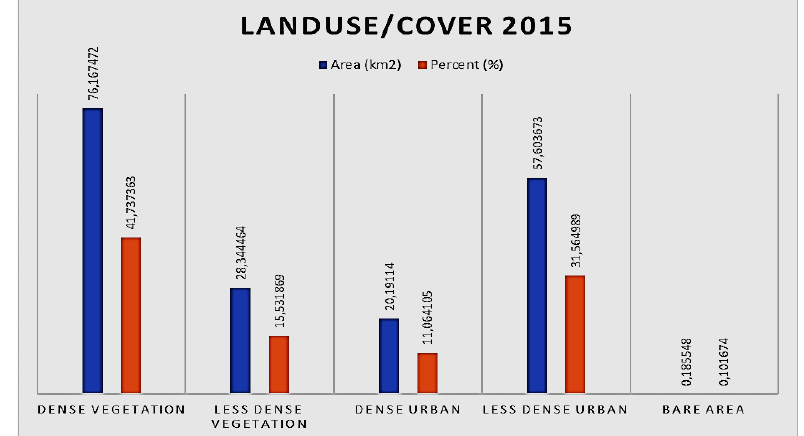
Figure 9. Land used/cover for 2015.